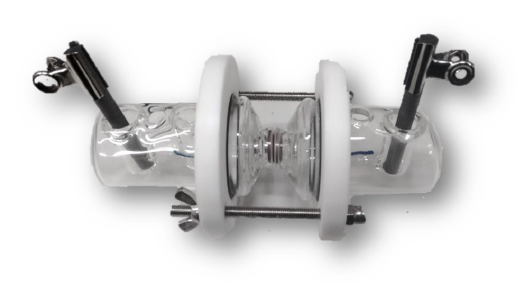
Figure 2. Double-compartment cell 25 used in the permeation tests and built in our laboratory 26 .